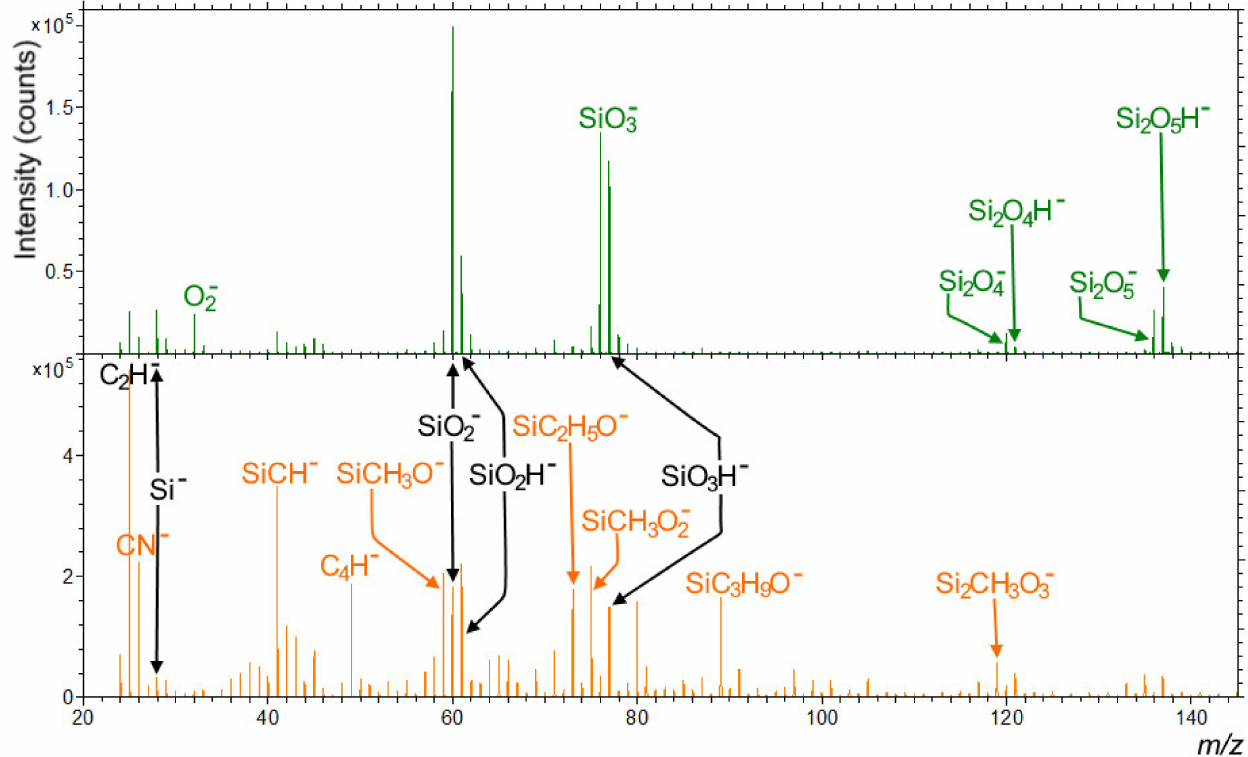
Figure 11. Negative secondary ion spectra of the HMDSO covered paper 1 by laboratory plasma reactor ( upper , green spectrum) and the one treated in an industrial plasma reactor ( bottom , orange spectrum) in the m/z range from 20 to 145. The most important peaks are assigned, with the green color representing only paper 1 treated in laboratory plasma reactor, orange representing only paper 1 treated in the industrial plasma reactor, and black representing signals equivalently found in both cases of the plasma